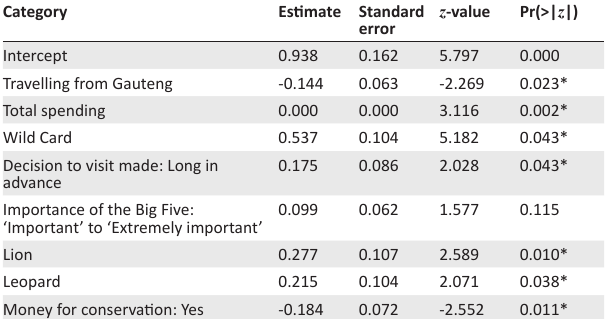
TABLE 4: Results of the stepwise Poisson regression